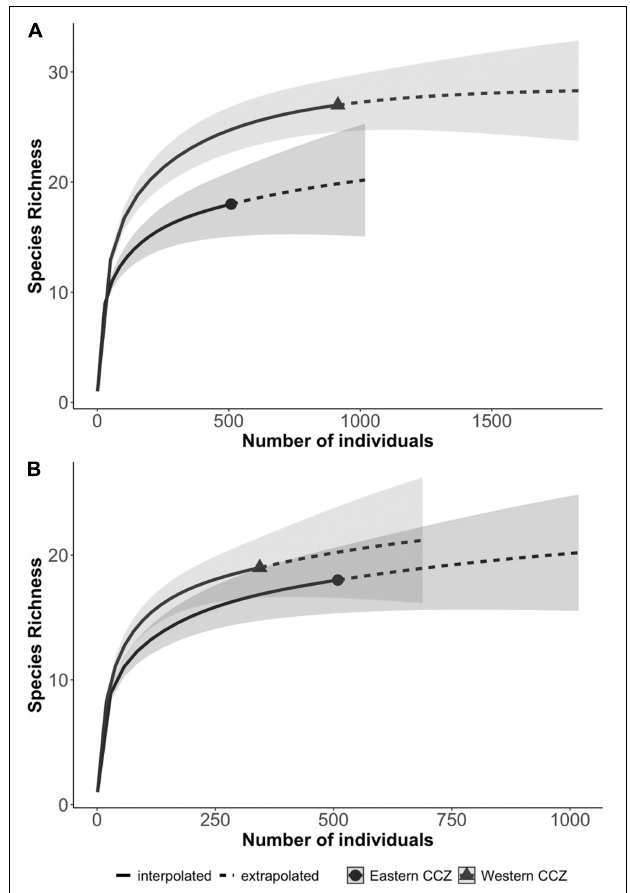
FIGURE 7 | Fish and scavenger diversity (estimated morphotype richness) compared between the eastern and western CCZ (A) including all CCZ baited camera deployments and (B) excluding all seamount deployments (bottom).